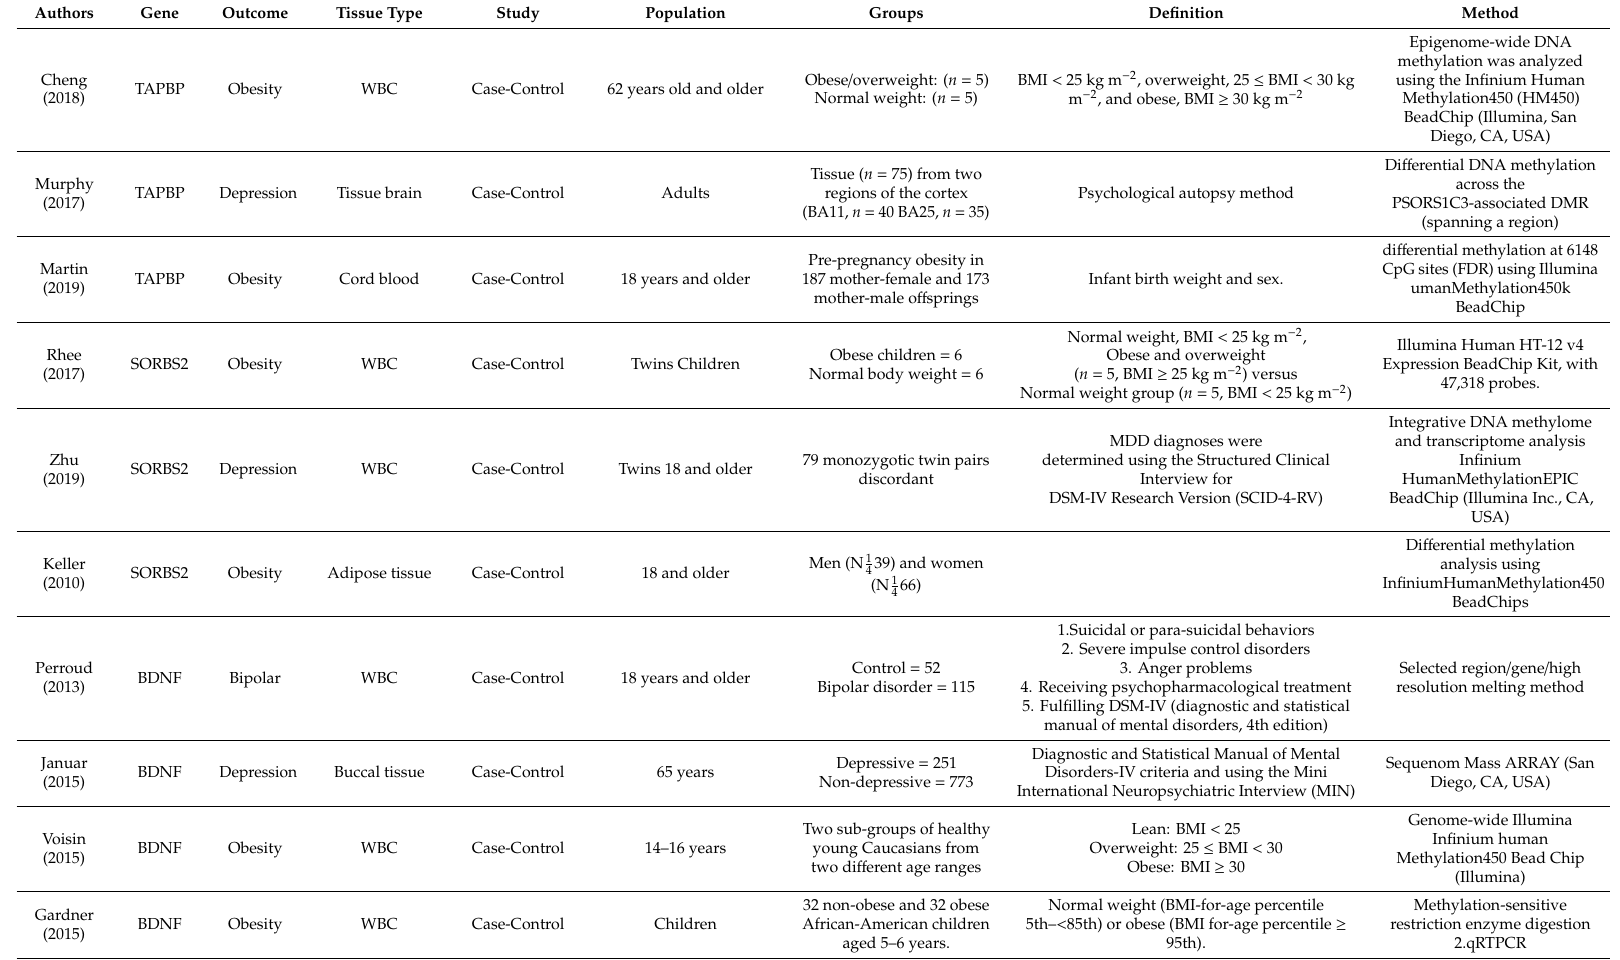
Table 1. Genomic regions investigated in reviewed